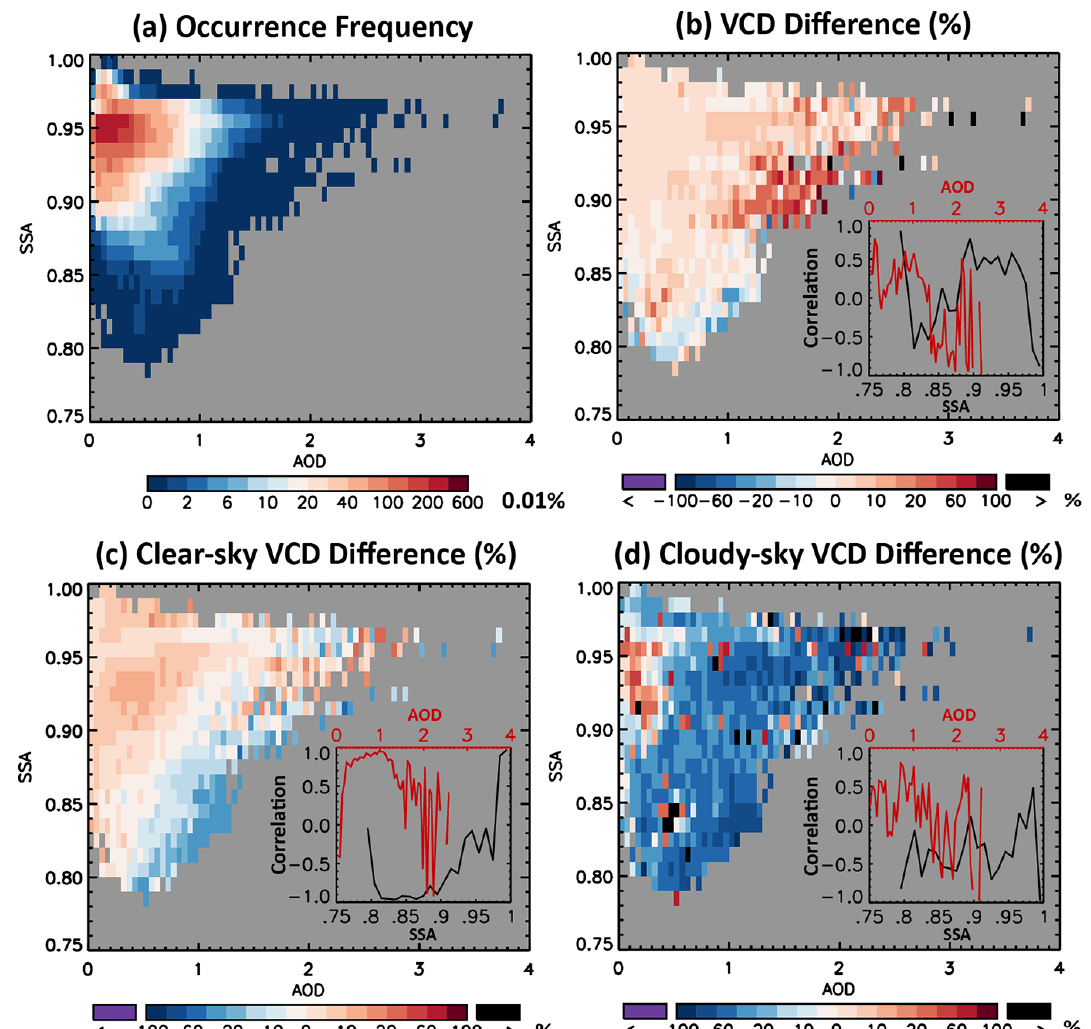
Figure 10. (a) Frequency of occurrence from all months and grid cells for each bin of AOD ( x axis, bin size 0.05) and SSA ( y axis, bin size 0.01). Data are sampled from valid pixels of case REF. (b) Percentage changes in NO 2 VCDs from case REF to SRF averaged over all data in each bin of AOD and SSA; also embedded are the correlations between percentage VCD changes and AOD values as a function of SSA values (black line) and between VCD changes and SSA values as a function of AOD values (red line). Similar panels are drawn for (c) clear-sky VCDs and (d) cloudy-sky